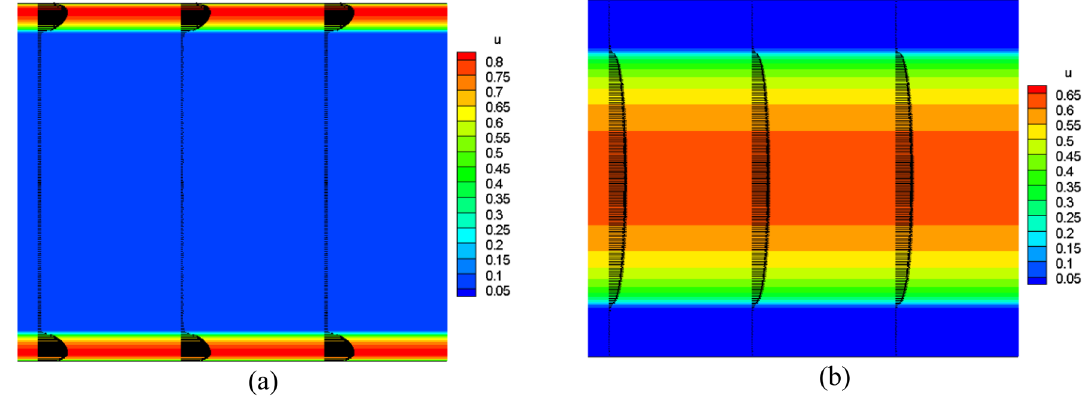
Fig. 14 Velocity (m/s) distribution and vectors in a central arrangement, b boundary